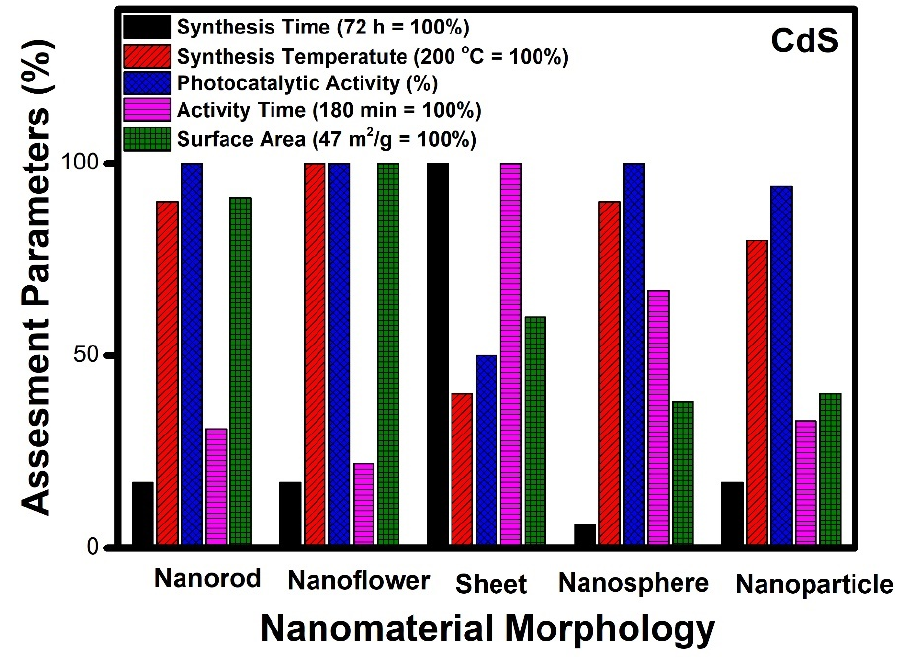
Figure 6. Comparative study of different morphologies of CdS based on various assessment param-